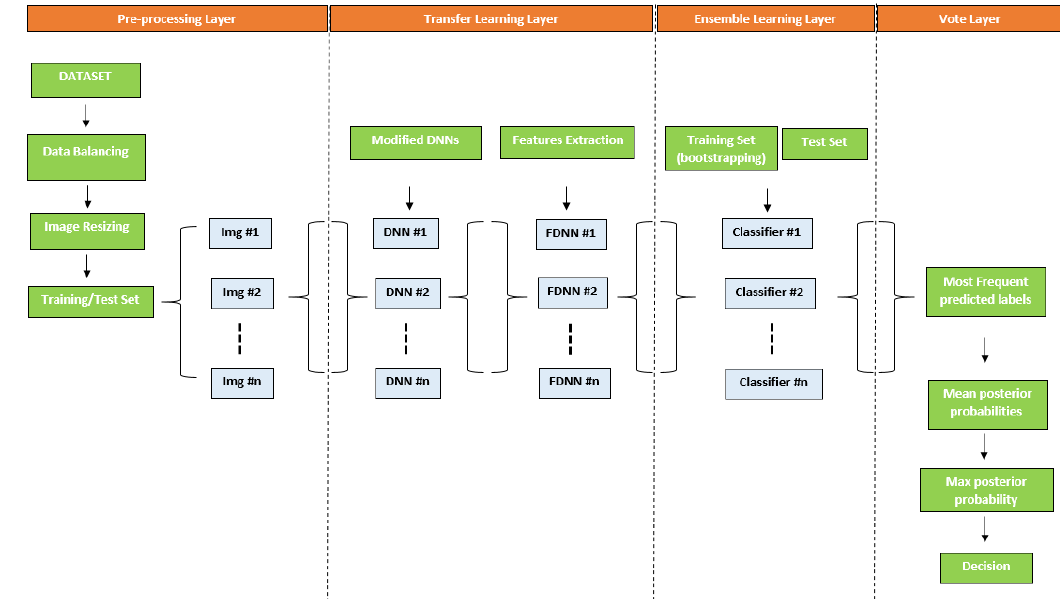
Figure 1. Overview of the proposed framework.